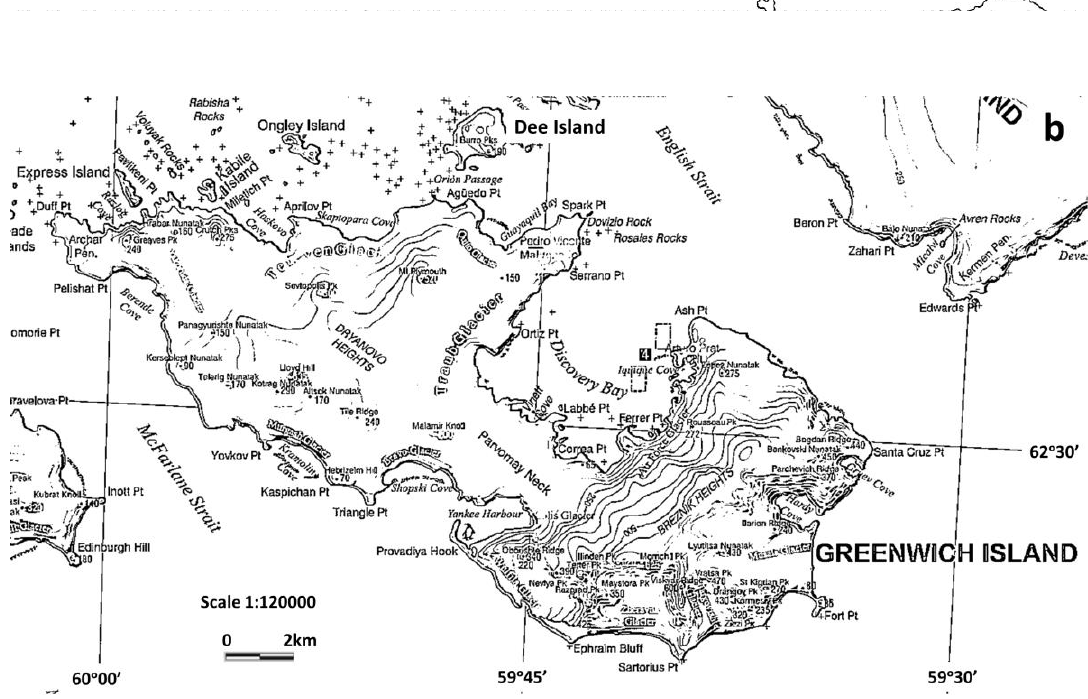
Figure 1: Map of the sampling sites, (a) The Antarctic continent with the Antarctic Peninsula in relief. The box indicated the location of Greenwich Island and Dee Island in South Shetland Islands and (b) Greenwich Island and Dee Island. (Adapted from Ivanov LL,